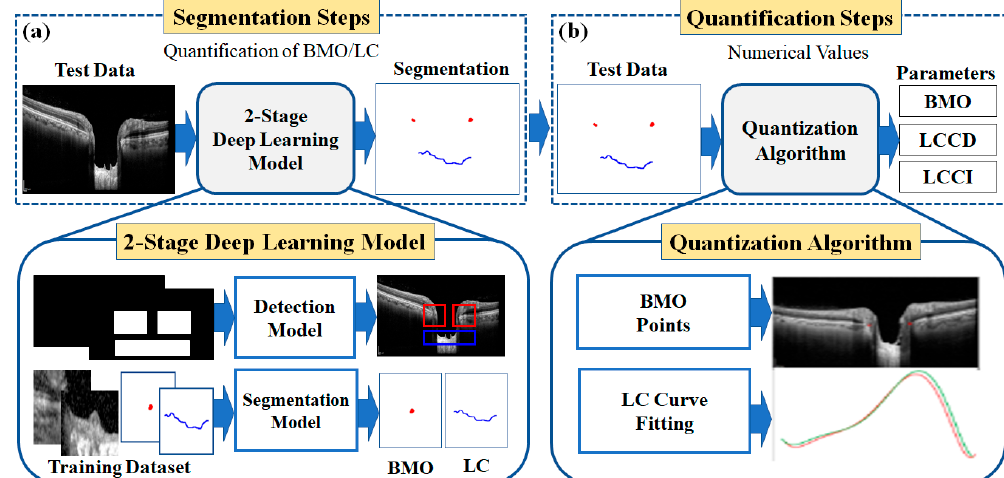
Figure 2. Overview of the proposed two-stage DL methods to quantify the BMO and LC morphological features: ( a ) seg- mentation steps consist of detection and a segmentation model for getting BMO and LC information; ( b ) quantification steps (LC depth ( LCD ), LC curve ( LCCD ), and LC curvature index ( LCCI ) numerical values calculation by image processing quantization algorithm from BMO and LC information).